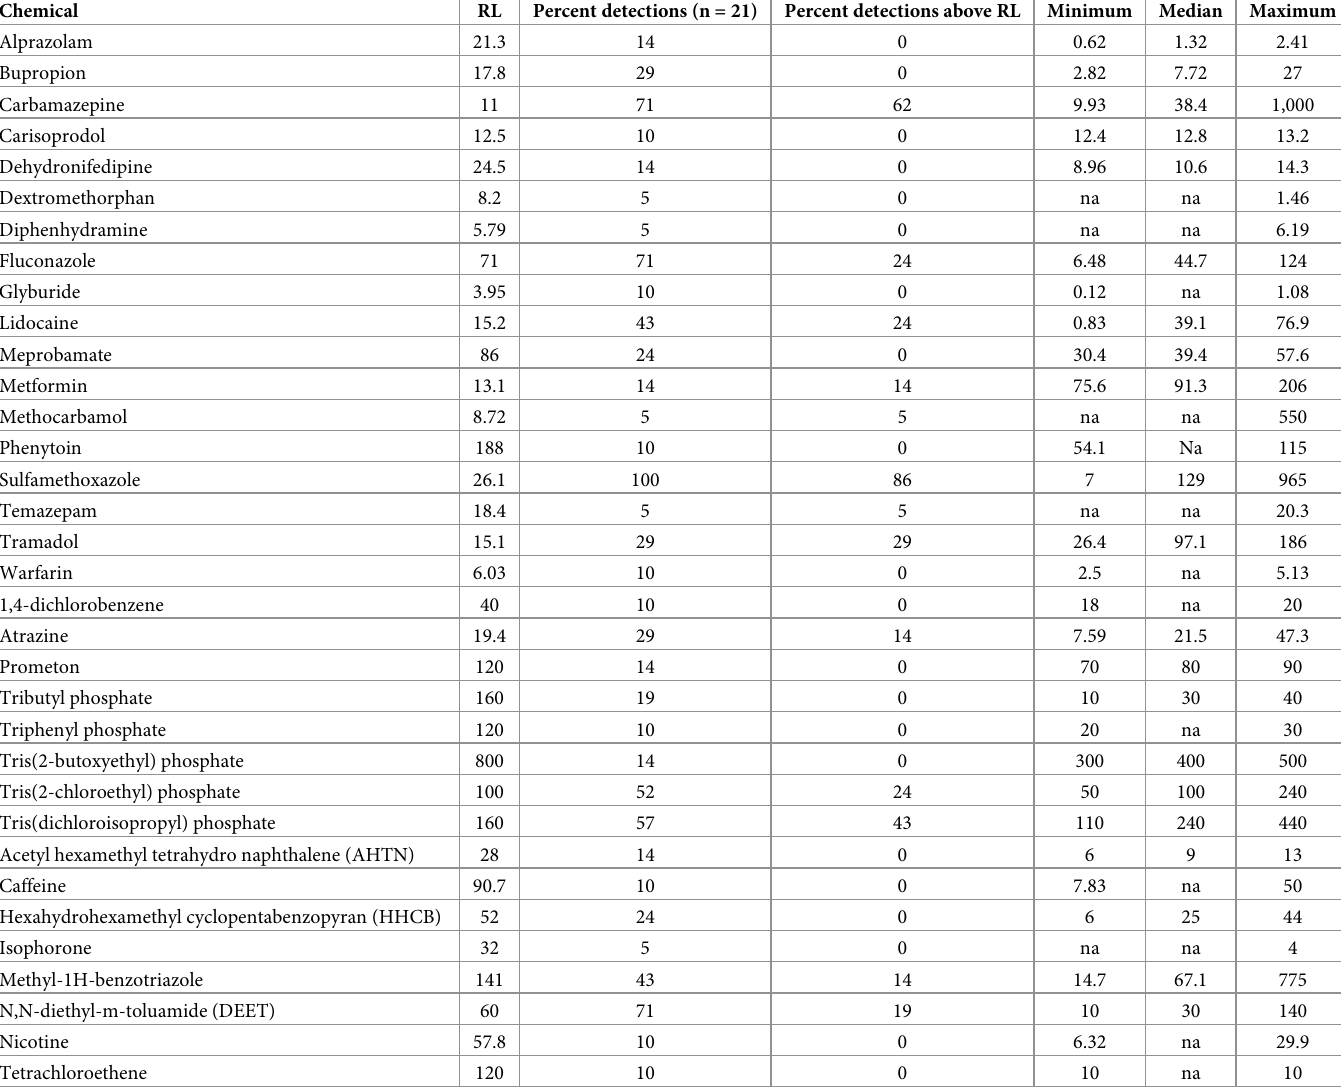
Table 3. Summary of micropollutant concentrations (ng/L) in groundwater samples collected downgradient from large subsurface treatment systems or rapid infil- tration